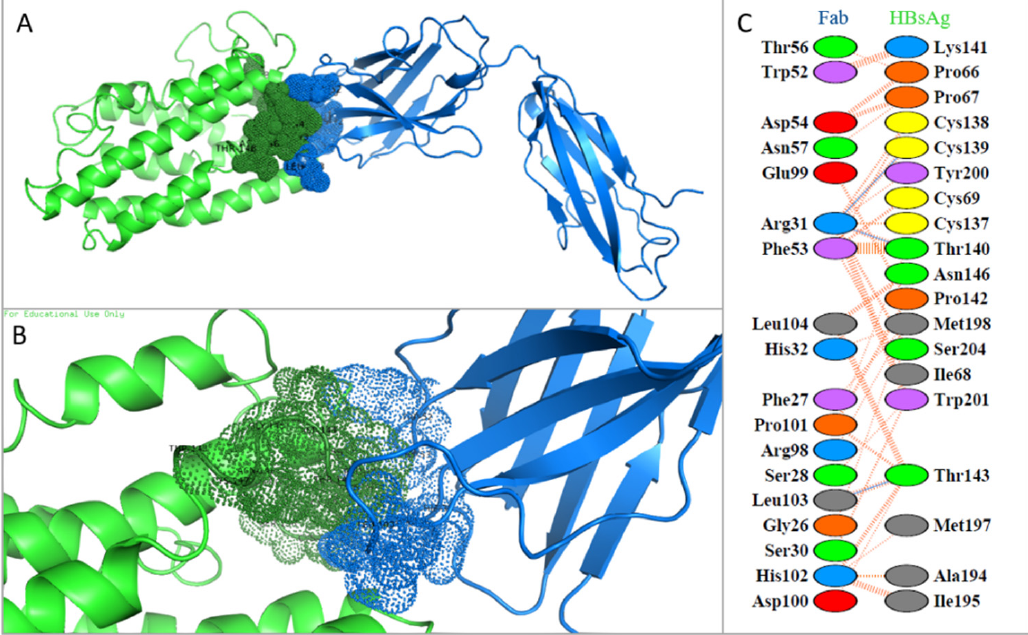
Figure 3. ( A ) Molecular docking between HBV-RO-10 and the heavy chain of the Fab fragment of antibody 6VJT (anti-HBs); ( B ) Site of interaction between the chains of the two proteins is highlighted; ( C ) Plot of hydrogen bonds (blue lines), nonbonded contacts (orange tick marks), and salt bridges (red lines) between residues on either side of the protein–protein interface. Images generated with PyMOL© and PDBSum©.